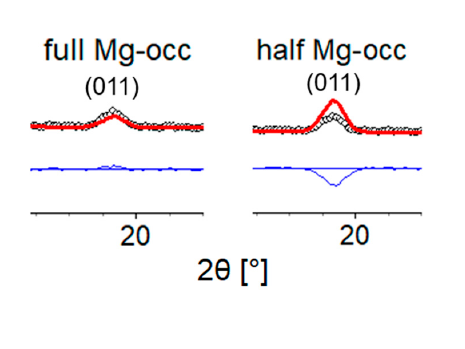
Figure 1. Mg occupancy of LAMT: ( a ) Discrepancy of the (011)-Bragg peak intensity on the NPD data between the full and half Mg occupancy; ( b ) (011)-plane in the monoclinic unit cell. Isotropic displacement parameters are visualized at the 50% probability level.